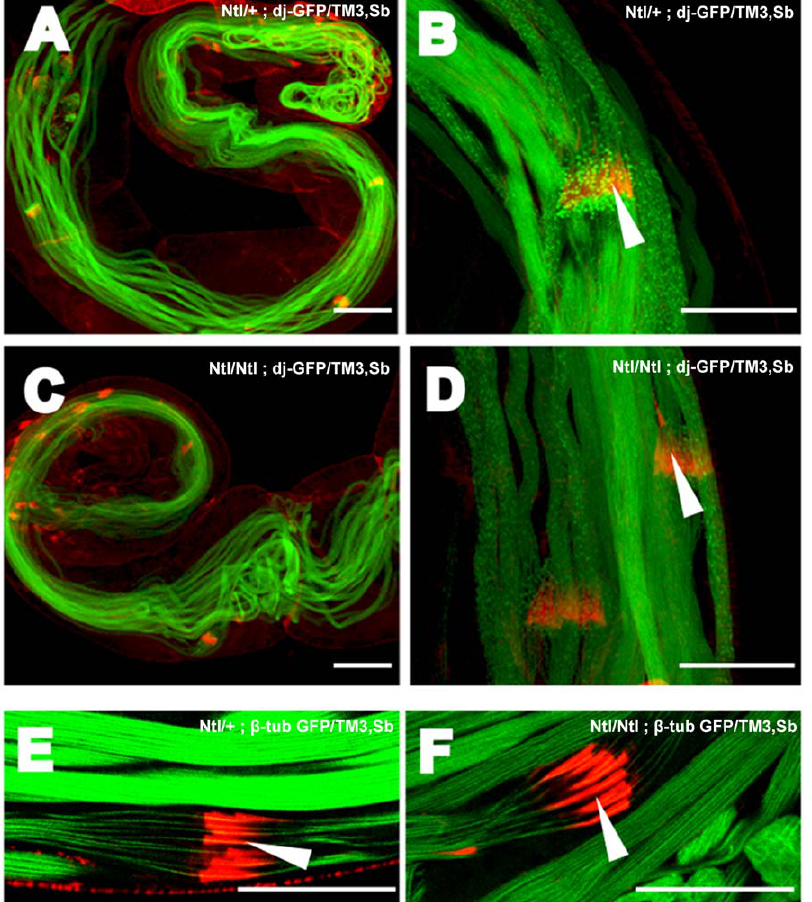
Figure 5. Individualization in Ntl mutants. A, B: wt testis expressing don juan -GFP counterstained with TRITC phalloidin to visualize the actin cone-based individualization complexes. Arrowhead marks the actin cones of the complex. C, D: Ntl mutant testis preparations expressing dj- GFP, counterstained with TRITC-phalloidin. Formation and movement of actin cones/individualization complex along the mutant cysts appears normal. E, F: TRITC-phalloidin staining of W.T. ( Ntl/ + ) (E) and Ntl mutant (F) cysts from males expressing b Tub- GFP. Bars, 20